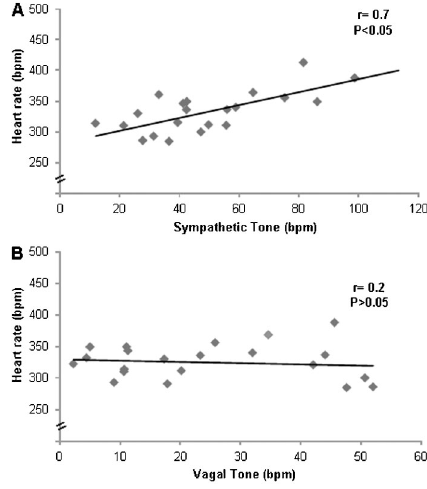
Figure 2. Correlations between A, resting heart rate and sympathetic tone (r=0.7, P , 0.05) and B, resting heart rate and vagal tone (r=0.2, P . 0.05). Pearson’s correlation coeffi- cients were determined using data from all hypertensive